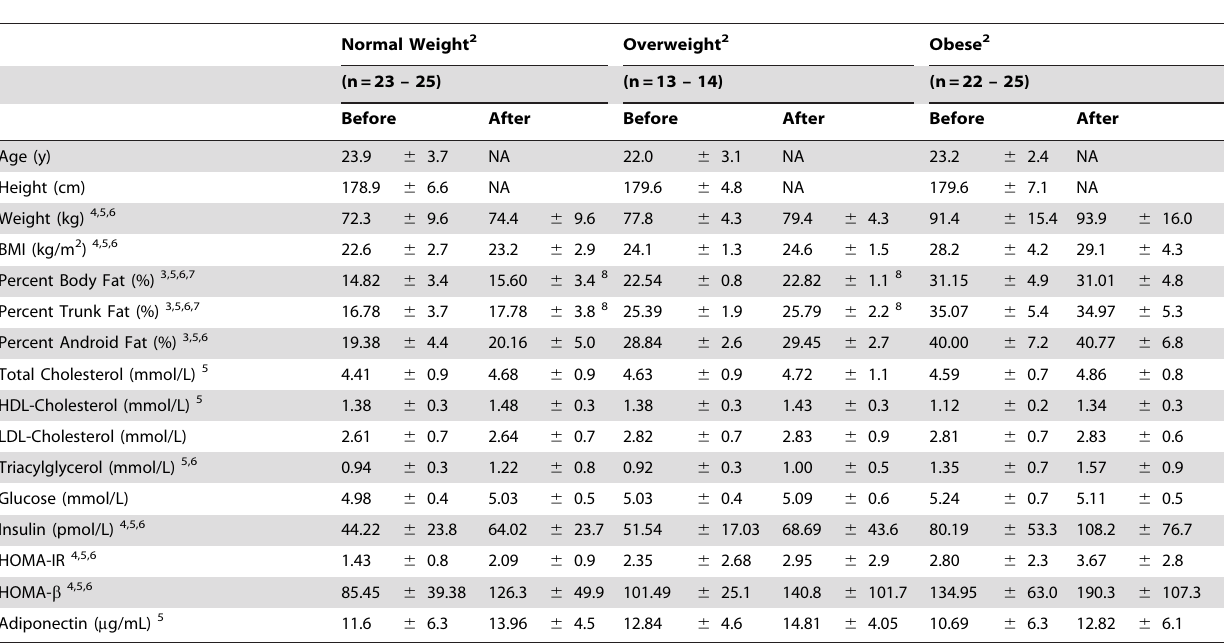
Table 1. Physical and biochemical characteristics of subjects at baseline and in response to 7-days of overfeeding 1